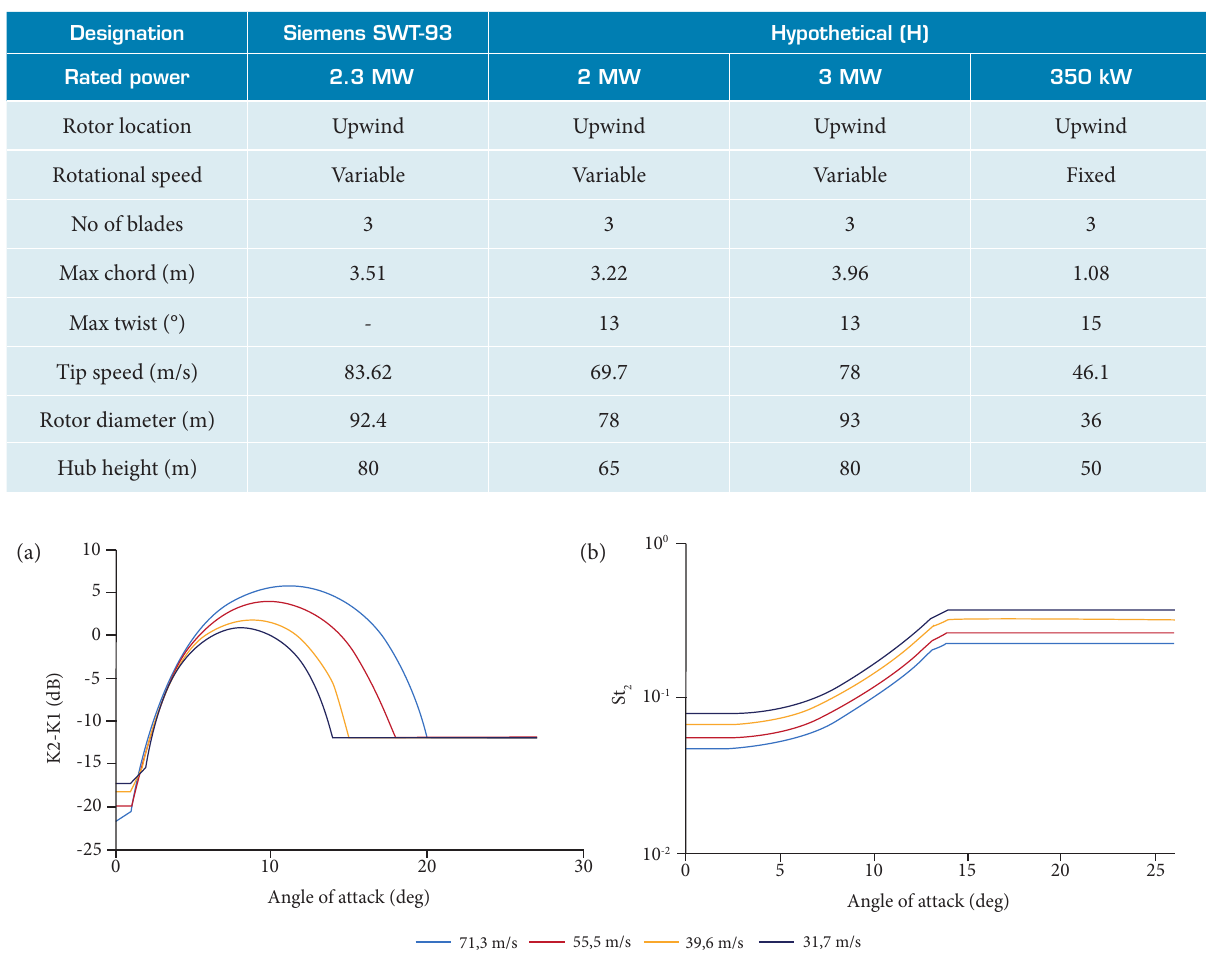
Table 2. Wind Turbine design specifications.